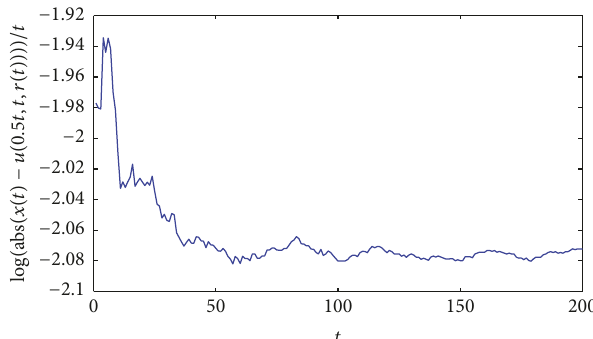
Figure 1: Computer simulation of ln |𝑥(𝑡) − 𝑢(𝑥(𝑡 − 𝛿(𝑡)),𝑡,𝑟(𝑡))|/𝑡 of the solution 𝑥(𝑡) of (74).